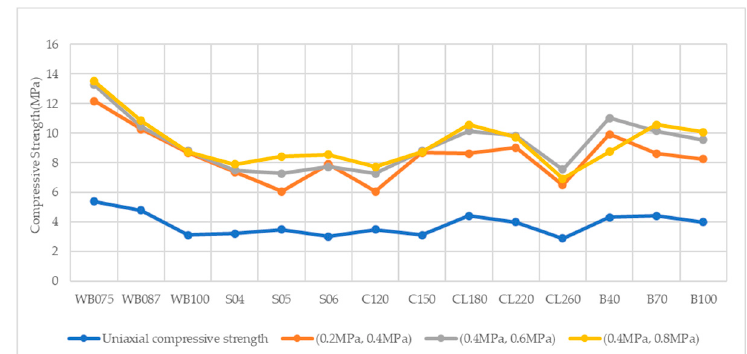
Figure 2. Compressive Strength under Different Confining Compression.